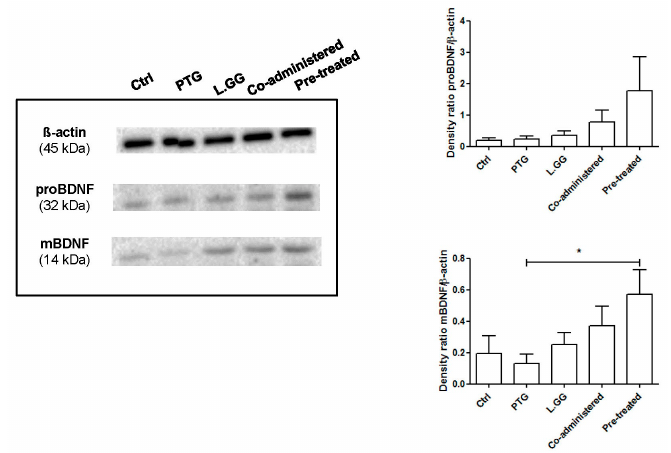
Figure 1. Western blot analysis of mBDNF and proBDNF in brain samples from control and treated rats, each group consisting of six rats. Immunoreactive bands were quantified using Image Lab Software (BioRad Laboratories Inc., Hercules, CA, USA). The graphs on the right show quantification of the intensity of bands calibrated to the intensity of the ß-actin band. All data represent the results of at least three independent experiments (mean plus SEM). * p < 0.05. Data were analyzed by Kruskal–Wallis analysis of variance and Dunn’s Multiple Comparison Test.